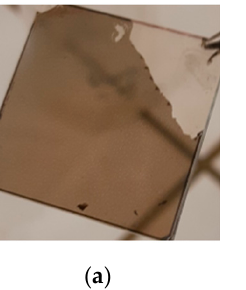
Figure 3. SEM photo of PPy synthesized from VPP.